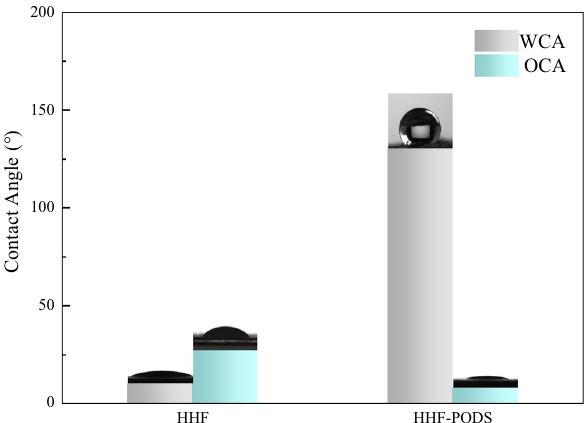
Figure 3. The different contact angles of water and oil on the HHF and HHF-PODS